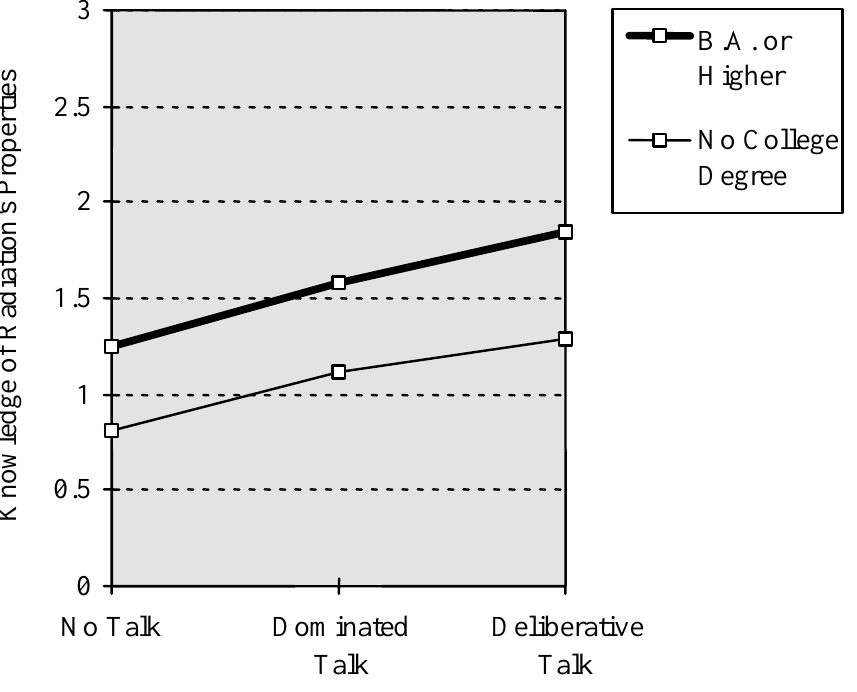
Relationships among Talk about the Lab, Educational Level, and Knowledge of Radiation’s Properties